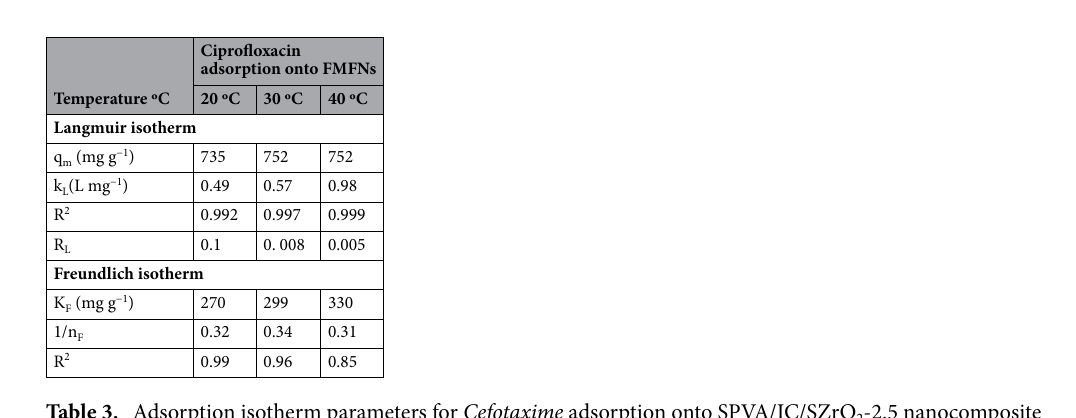
Table 3. Adsorption isotherm parameters for Cefotaxime adsorption onto SPVA/IC/SZrO 2 -2.5 nanocomposite beads at adsorbent dosage 0.2 mg mL −1